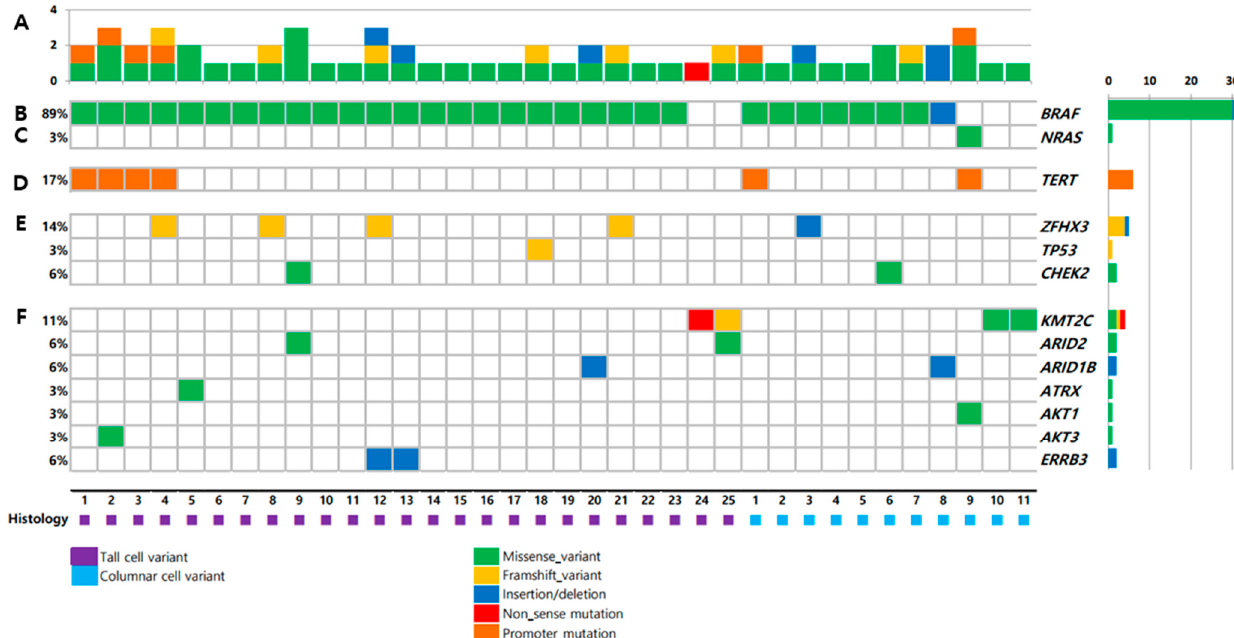
Figure 1. Mutations in tumors from 36 patients: ( A ) number of mutations; ( B ) BRAF ; ( C ) NRAS ; ( D ) TERT promoter; ( E ) tumor suppressor genes; ( F ) key pathways and functional groups.